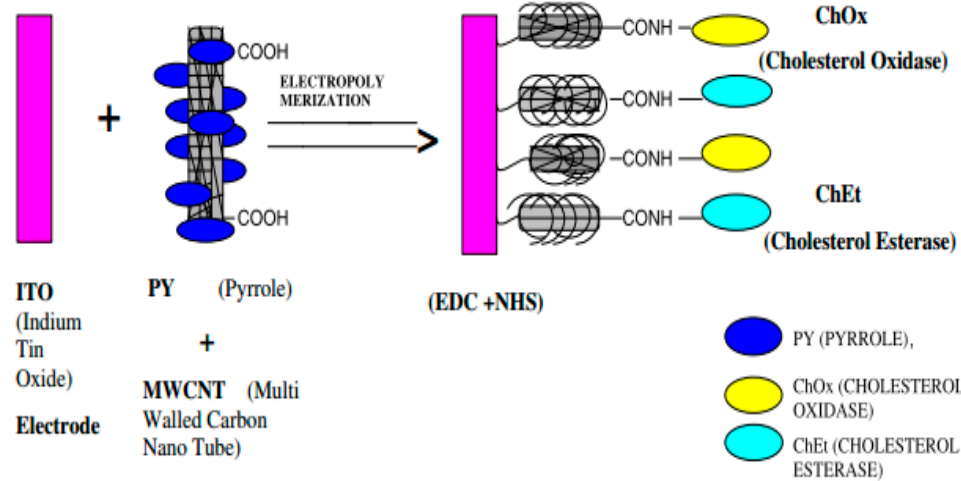
Figure 12. Fabrication of nanocomposite electrode (taken from [138]).